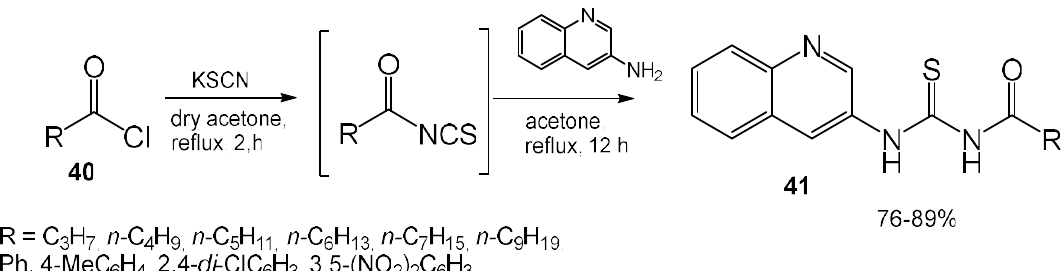
Fig. 12. “One-pot two-step” synthesis of acylthioureas and diacyl-bis-thioureas